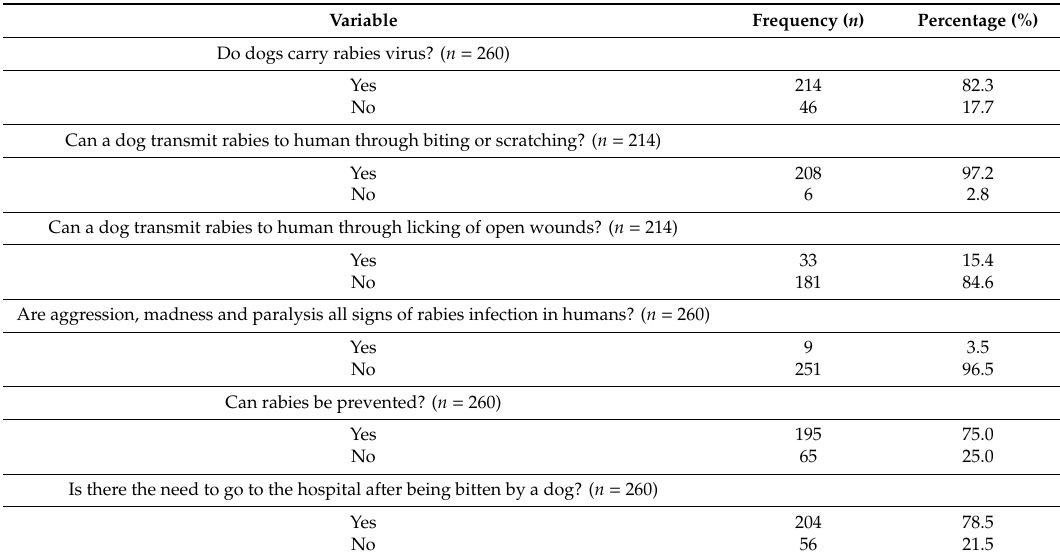
Table 2. Knowledge of dog owners about